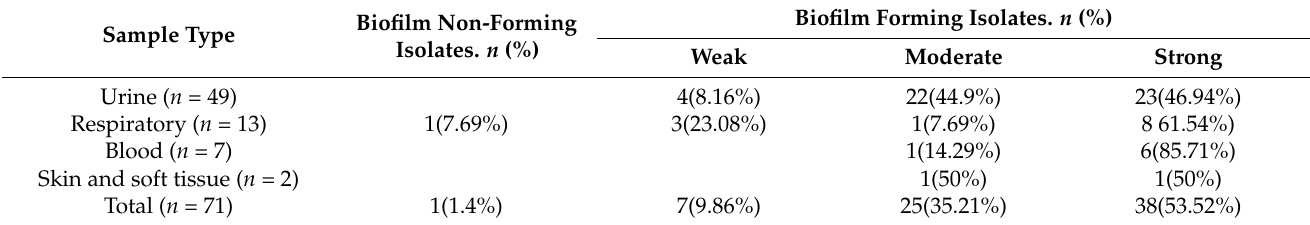
Figure 2. Determination of biofilm production by ( A ) visual method and ( B ) spectrophotometric method. Table 3. Description of biofilm production among C. tropicalis isolates.